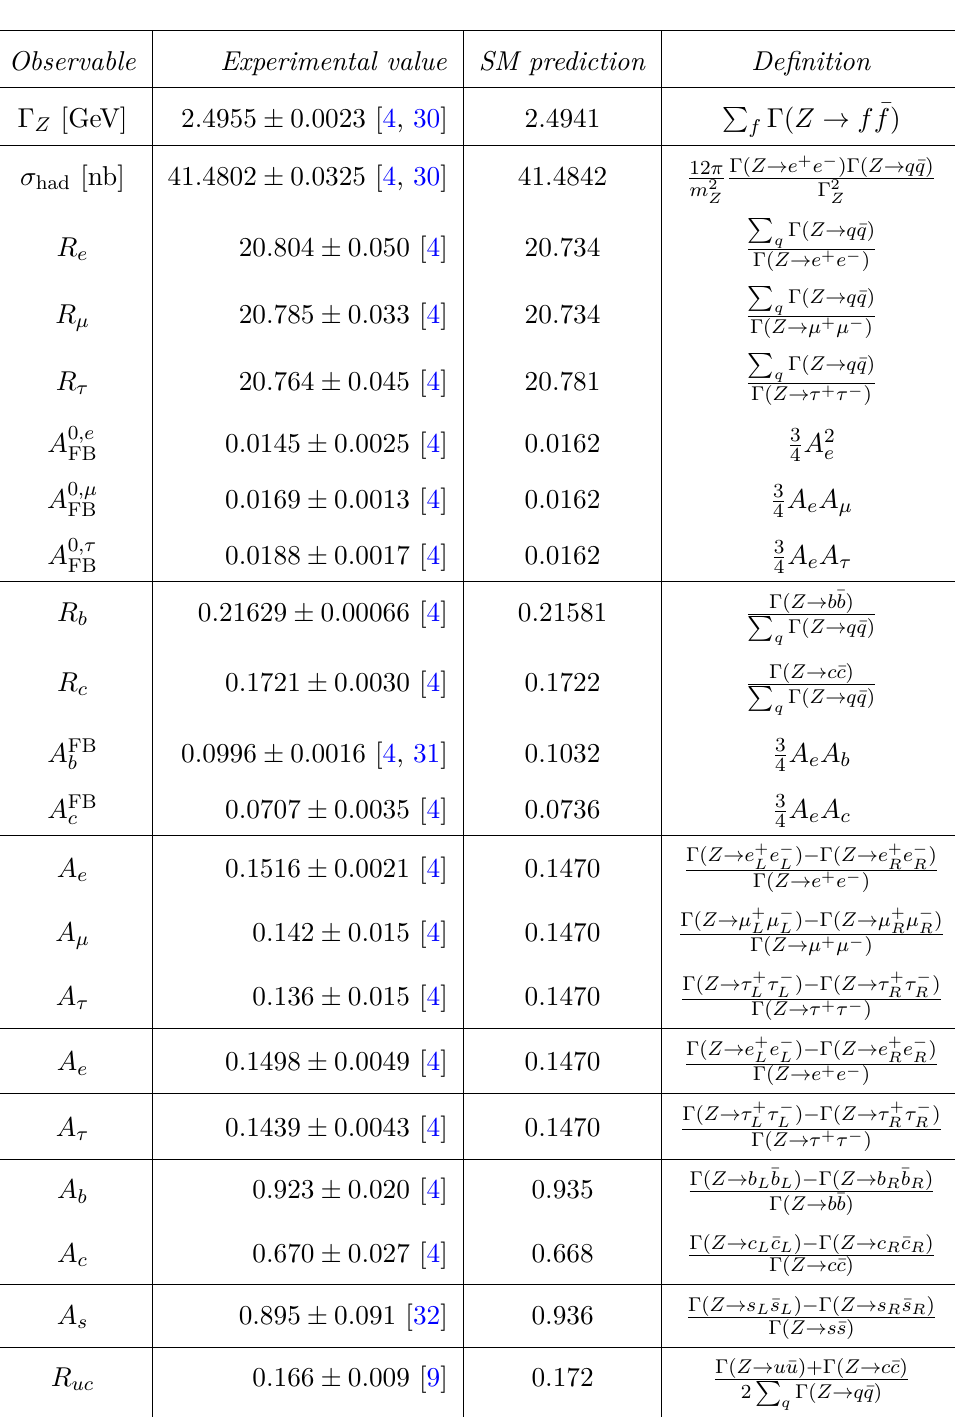
Table 1 . Z pole observables . The experimental errors of the observables not separated by horizontal lines are correlated, which is taken into account in the fit. The first A e and A τ values come from the combination of leptonic polarization and left-right asymmetry measurements at SLD, while the second values come from the LEP-1 measurements of the polarization of the τ ± leptons.